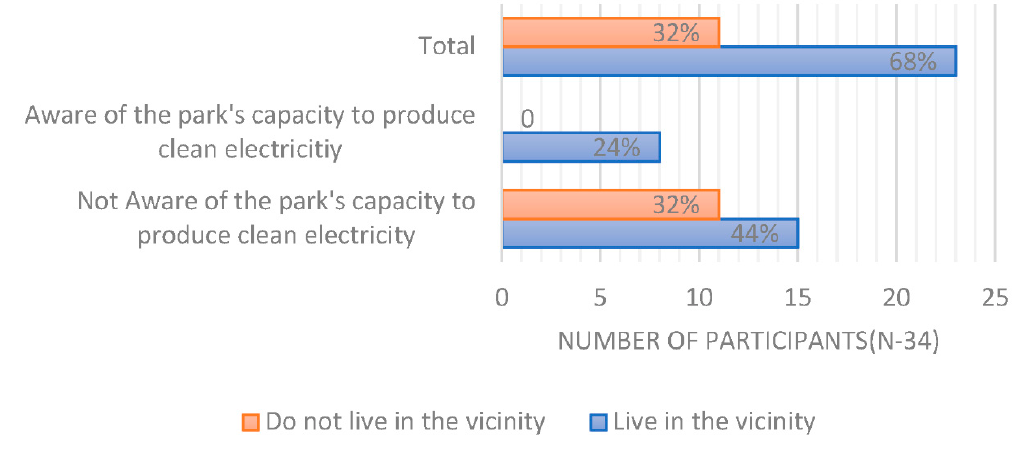
Figure 7. Survey results revealing user’s response to the park’s renewable energy.